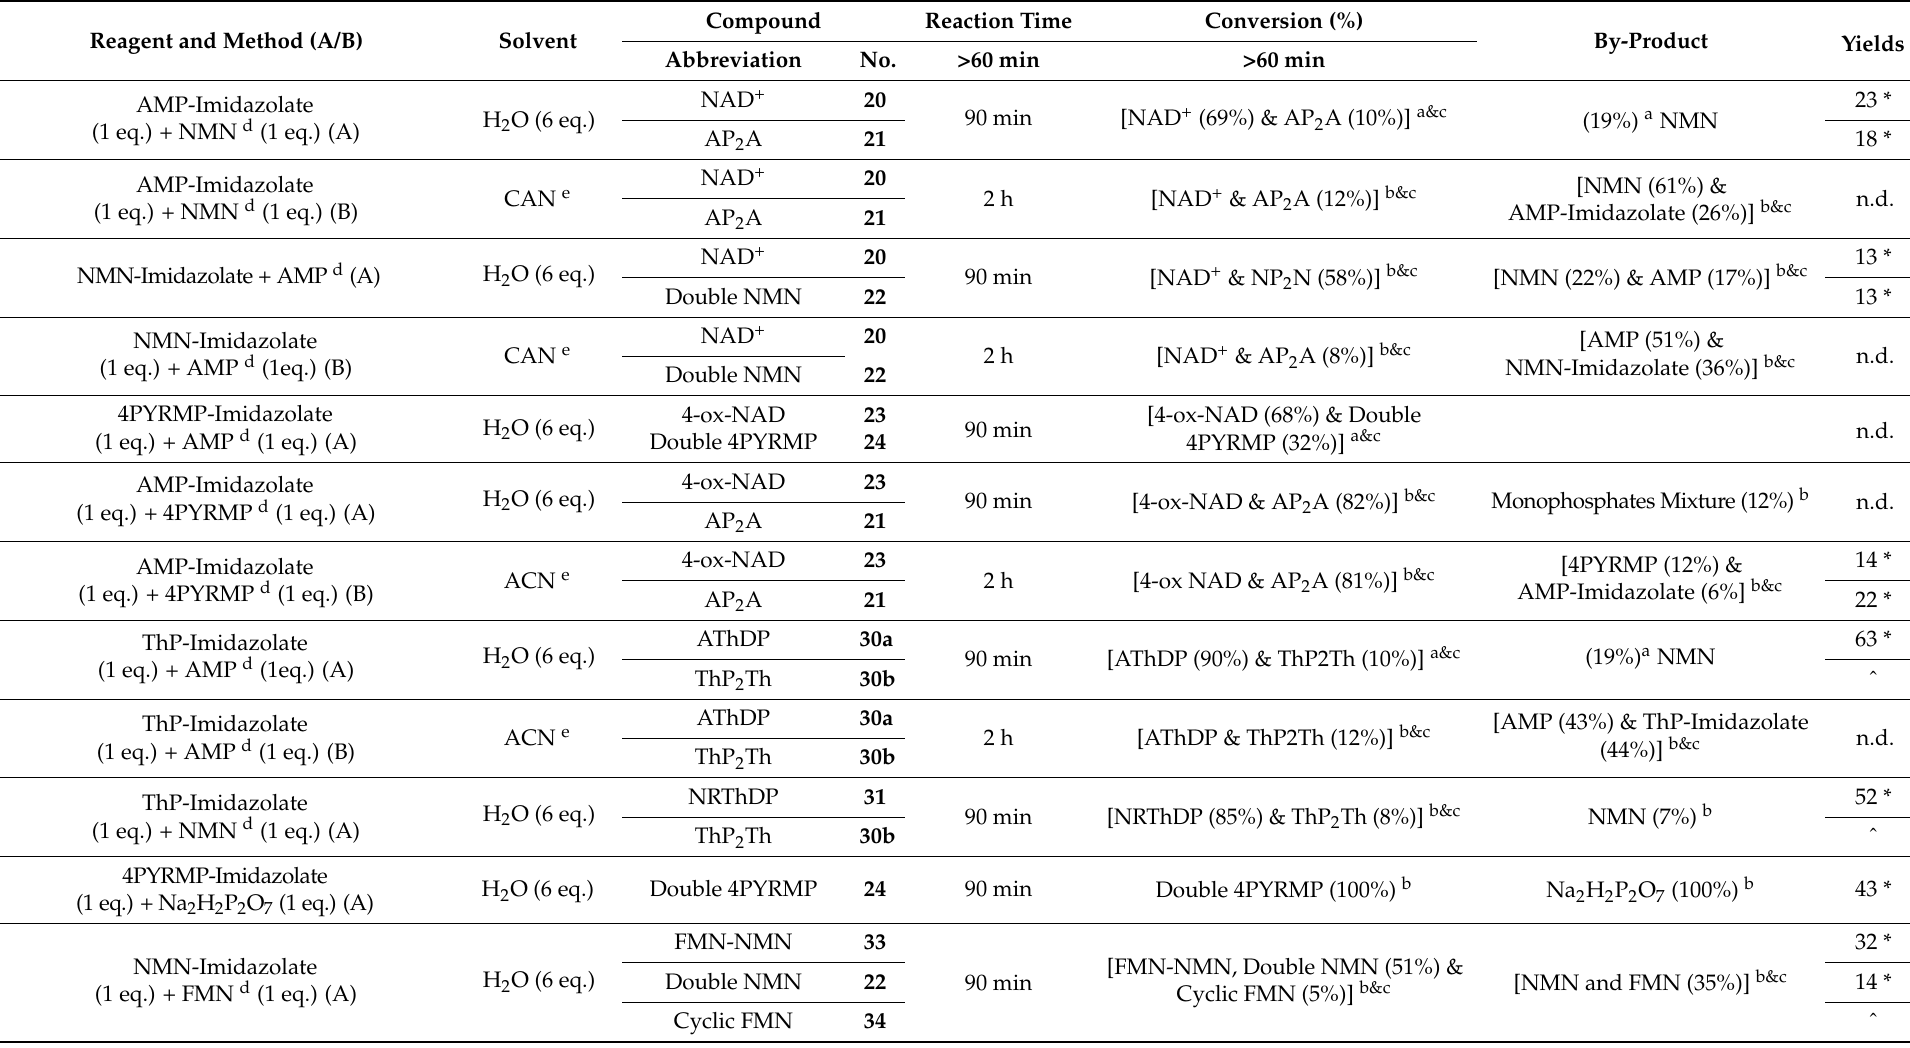
Table 2. Stepwise conditions, reaction time, conversions, and isolated yields of pyrophosphate bond